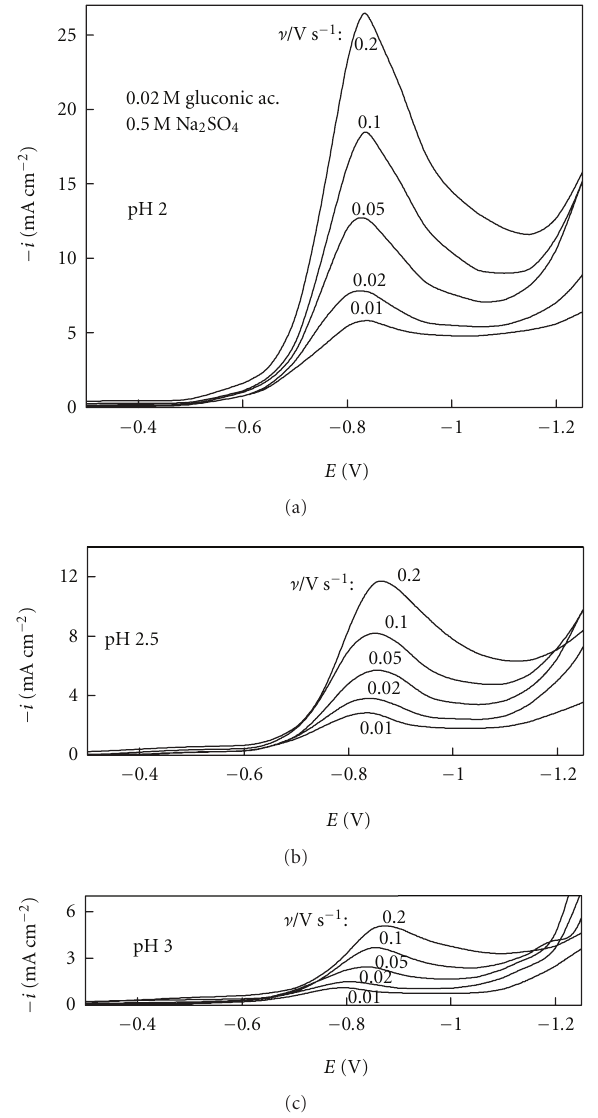
Figure 2: Voltammograms obtained for 0.02 M gluconic acid solutions containing 0.5 M Na 2 SO 4 at di ff erent pH. Potential sweep rates are indicated at the respective curves.